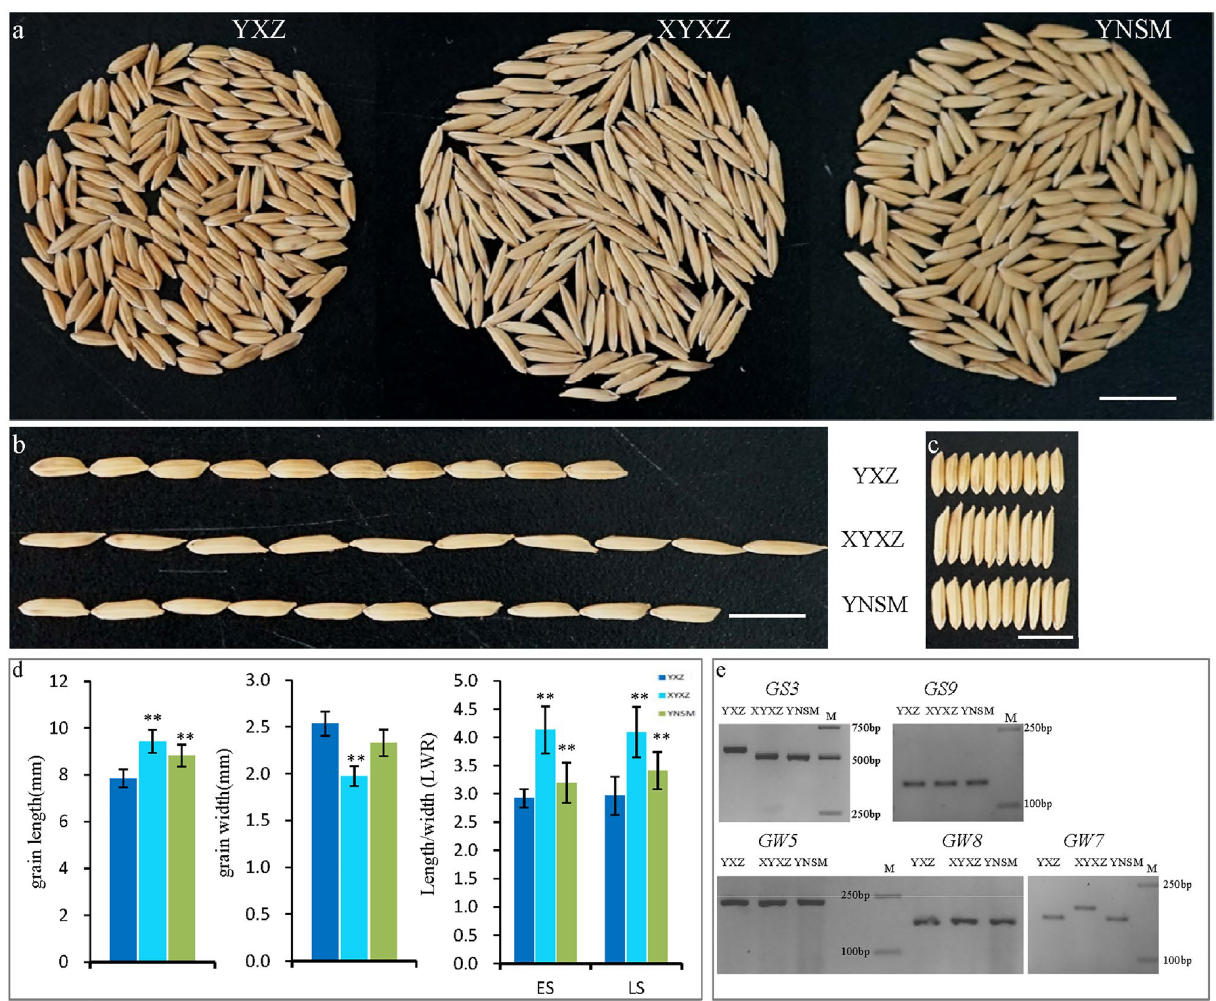
Figure 2. Grain appearance. ( a ), Rice grain appearance (n = 150 grains); ( b ), 10-grain length of 3 varieties; ( c ), 10-grain width of 3 varieties; ( d ), Statistical analysis of grain length, grain width and length/width ratio (LWR), ES, early season, LS, late season; ( e ), genotype of LWR genes. ES, early season; LS, late season; M, marker; Bar = 1